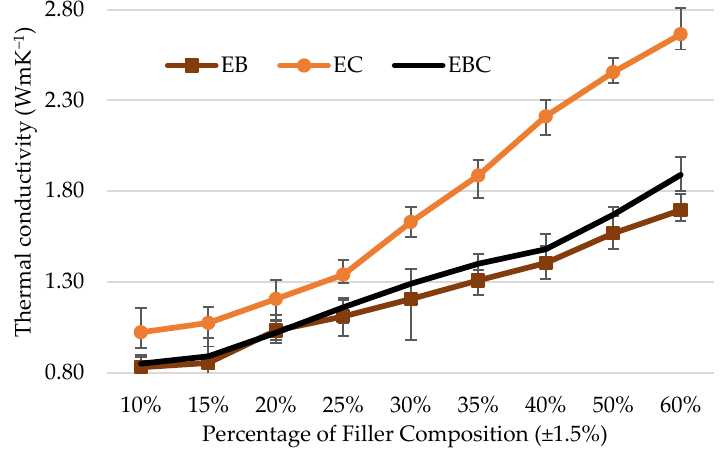
Figure 18. Thermal conductivity test result for EBC filler.